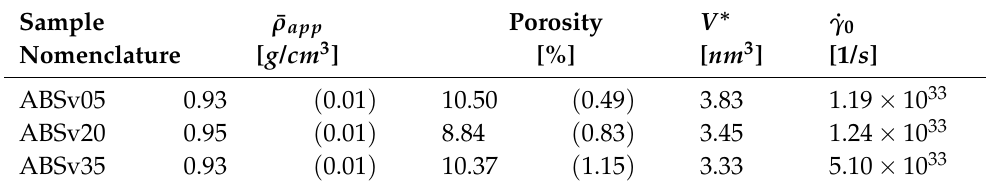
Table 3. Average apparent density, porosity, and model parameters used to describe the yield behavior of the ME-AM samples. Standard deviations are indicated between brackets.